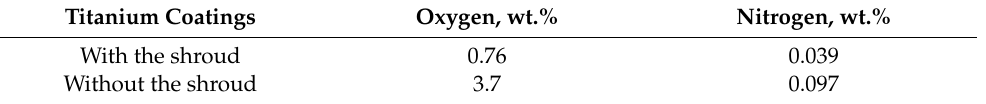
Table 3. The contents of nitrogen and oxygen in the plasma-sprayed titanium